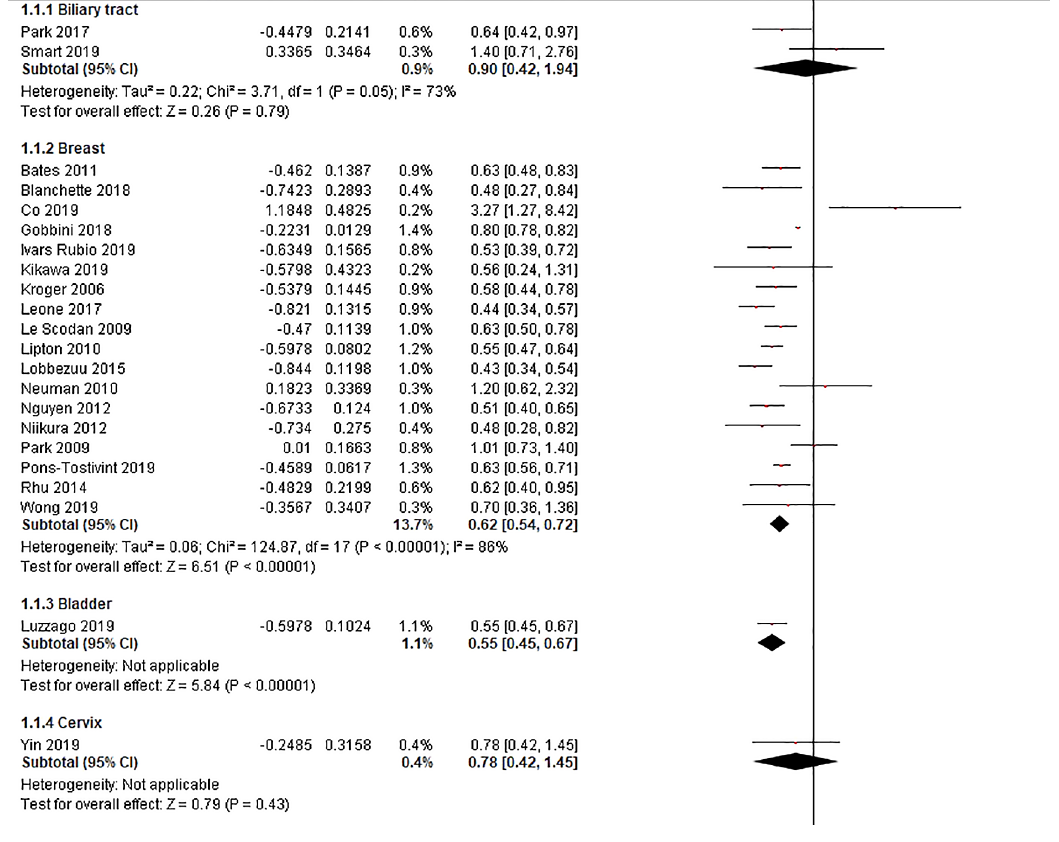
Figure 3. Overall survival of oligo- compared to non-oligometastatic